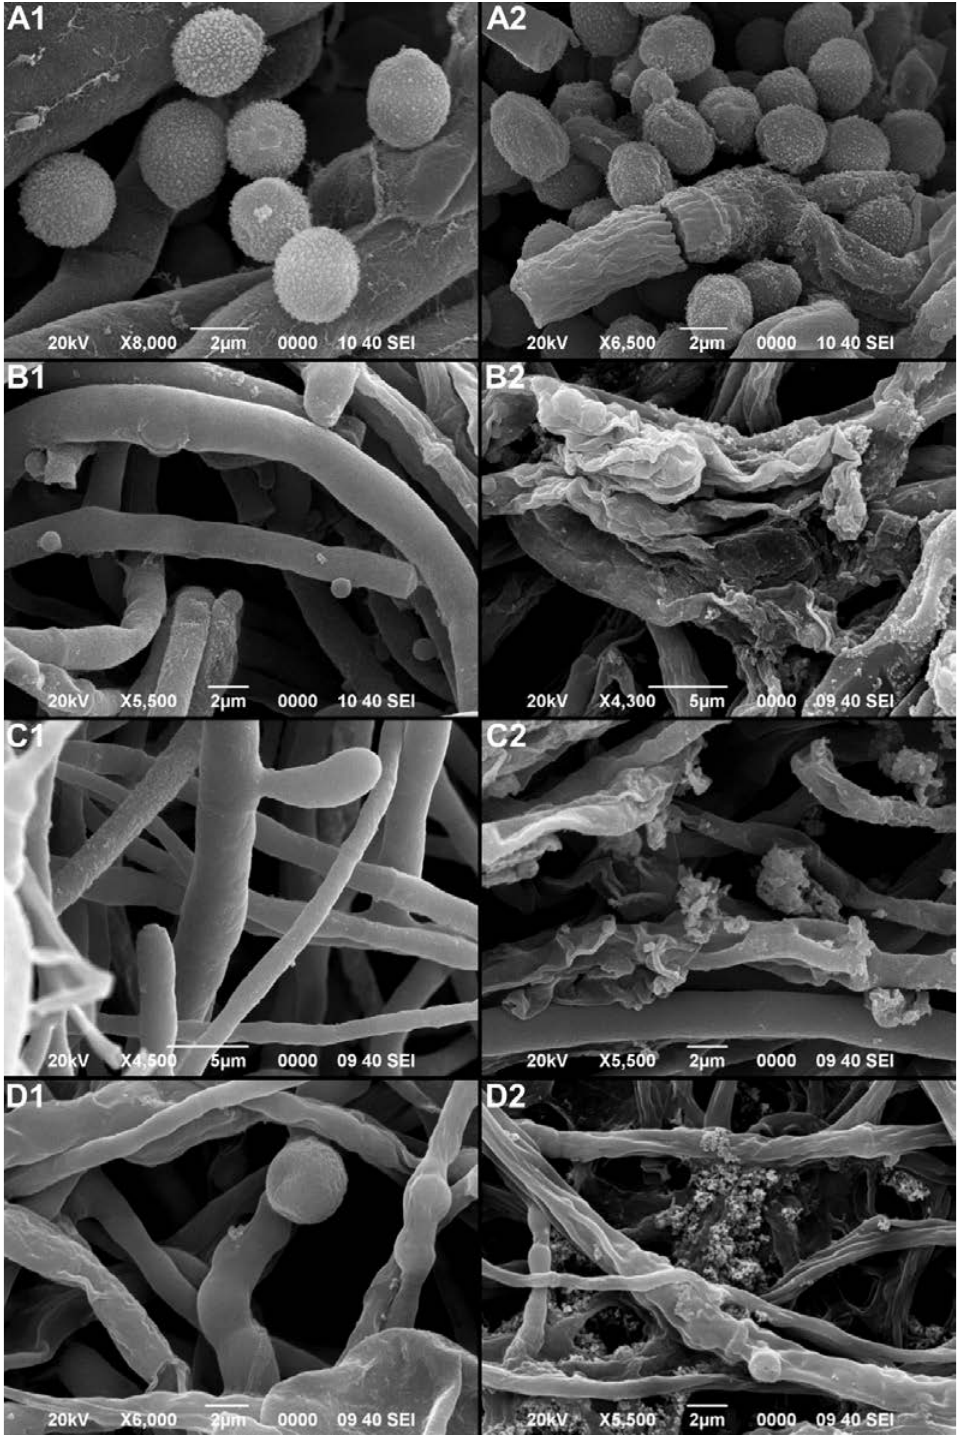
Figure 7. Scanning electron microscope images showing the effects of P aib over the morphology of untreated fungus ( 1 ) and fungi treated with P aib ( 2 ). ( A ) C. gloeosporioides; ( B ) B. cinerea; ( C ) A. alter- nata and ( D ) F. oxysporum